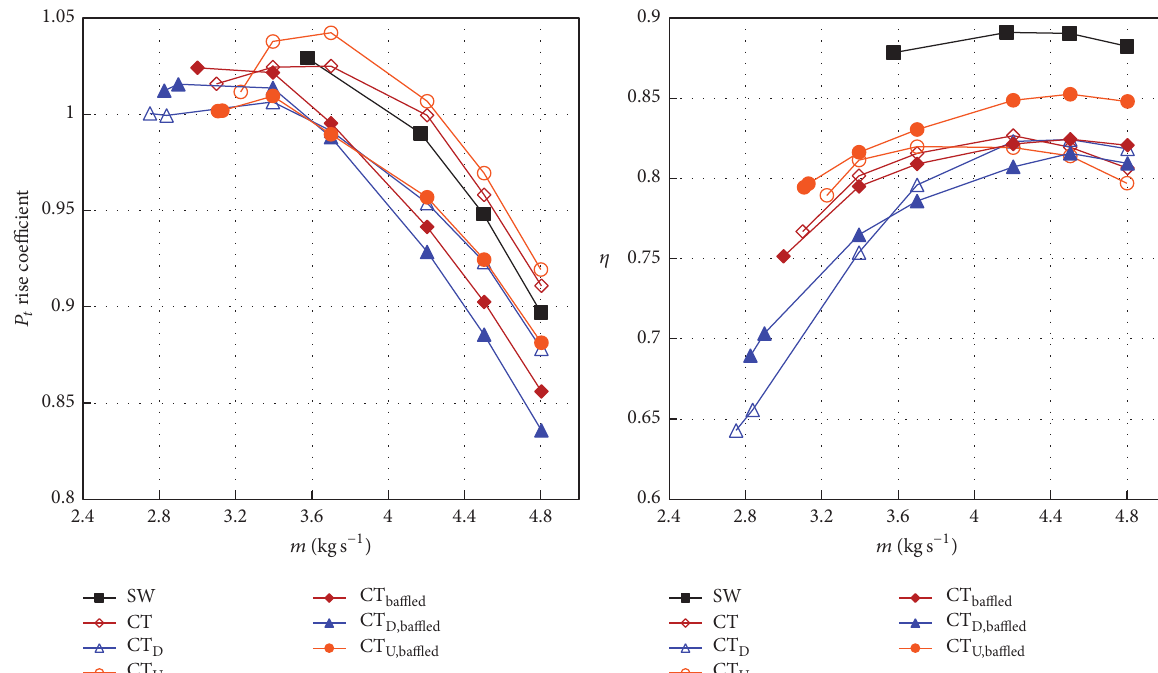
Figure 9: Total performance of different slot